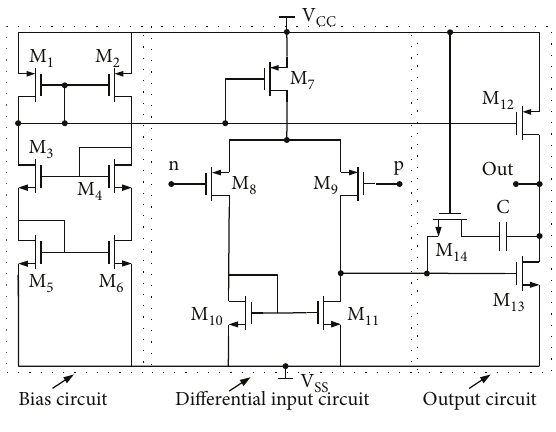
Figure 1: The designed OA.